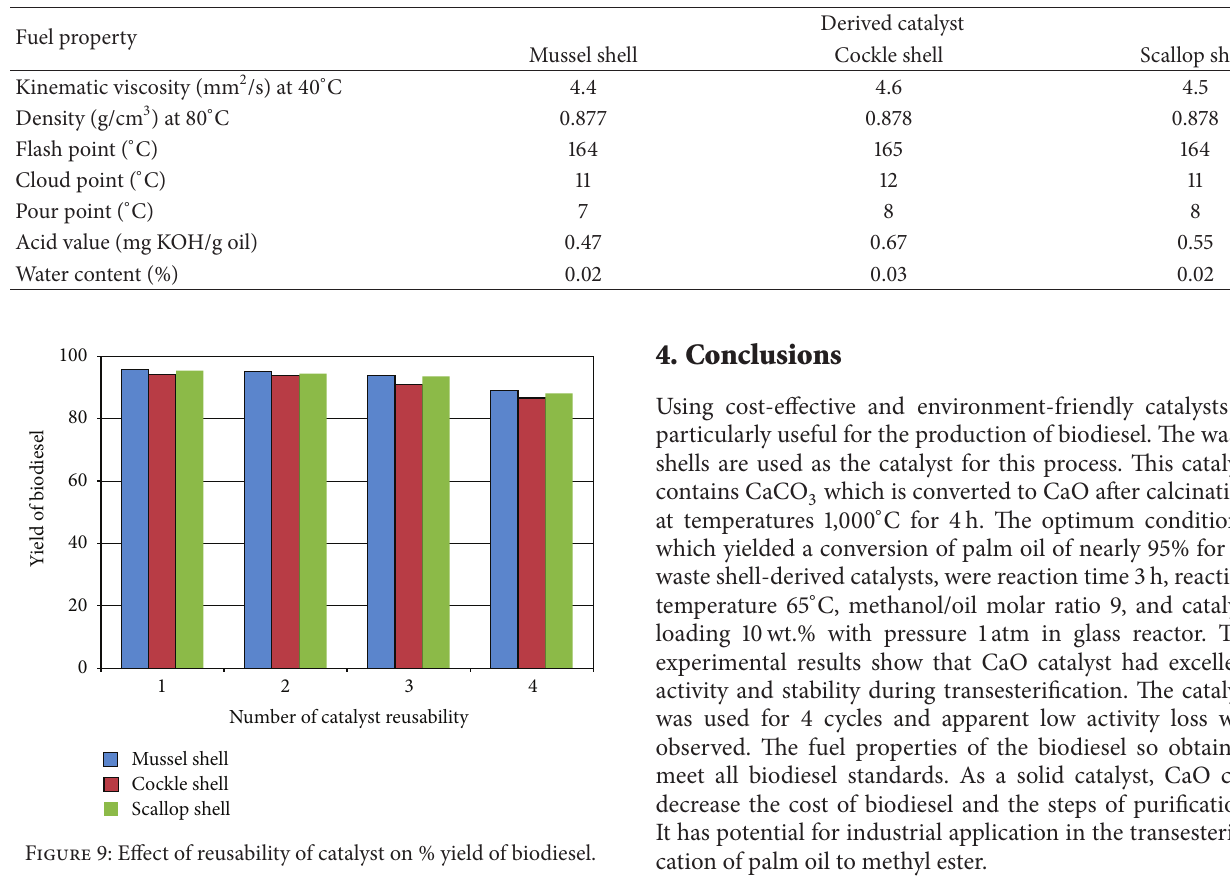
suitable amount of CaO required for the transesterification of palm oil is 10